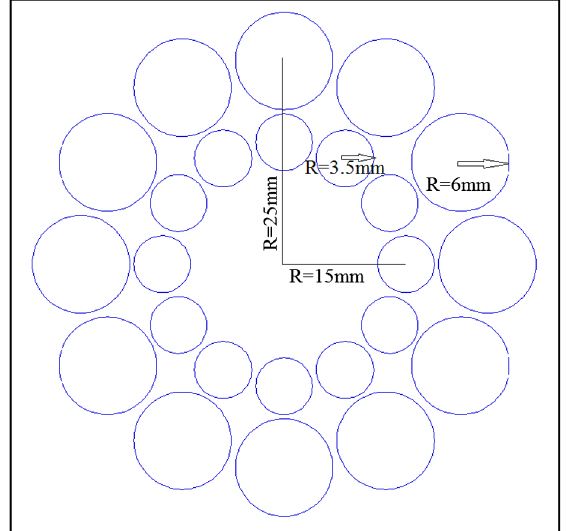
FIG. 16. Arrangement of magnets in two layers for producing an 80 . 83 T/m quadrupole gradient. The radius of each magnet for the inner and outer layers is 3.5 and 6 mm,